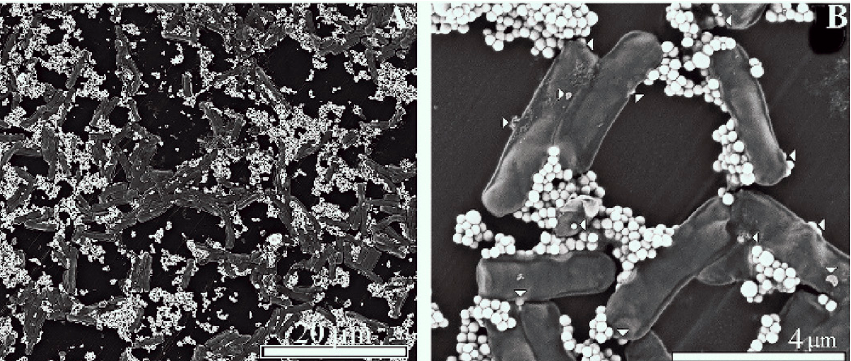
Figure 2. Scanning electron microscopy of lactomicroSel particles produced by Lactobacillus casei. ( A ) Visualization of lactomicroSel particles at low magnification. Scale bar, 20 μ m; and ( B ) lactomicroSel particles at higher magnification. White arrows show the sites of bacilli where the nanoparticles are being excreted. Scale bar, 4 μ m.